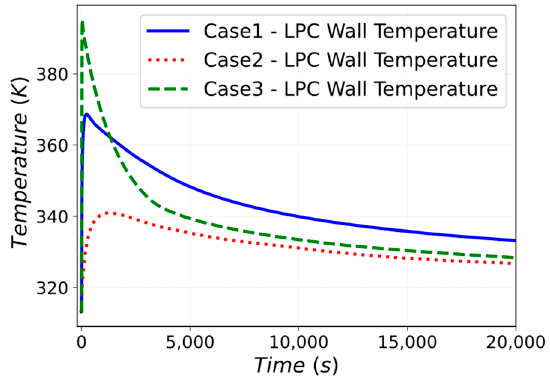
Figure 15. Temperature trend of the LPC wall.